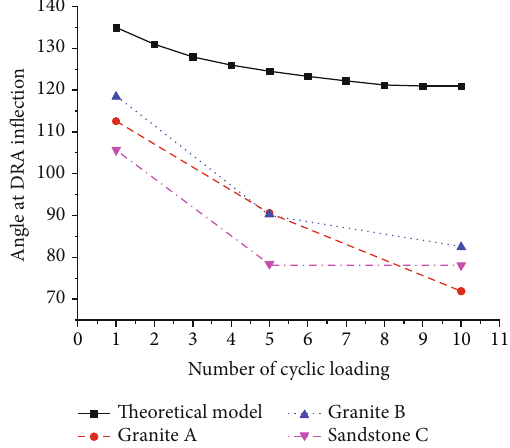
Figure 15: Comparison of DRA angle between the theoretical model and the experiment.